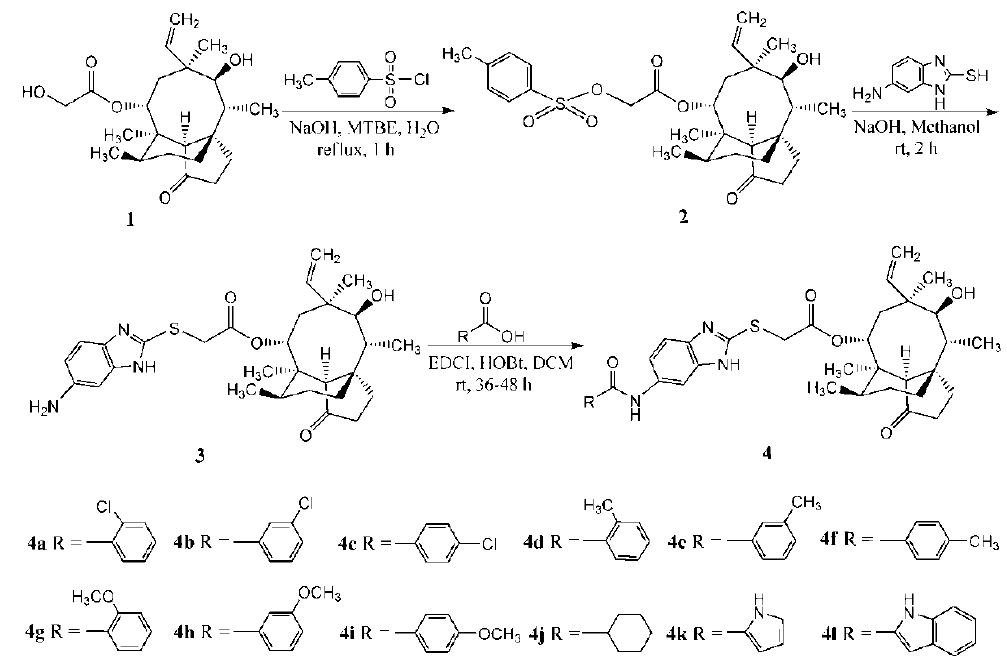
Scheme 1. General synthetic scheme for the pleuromutilin derivatives.